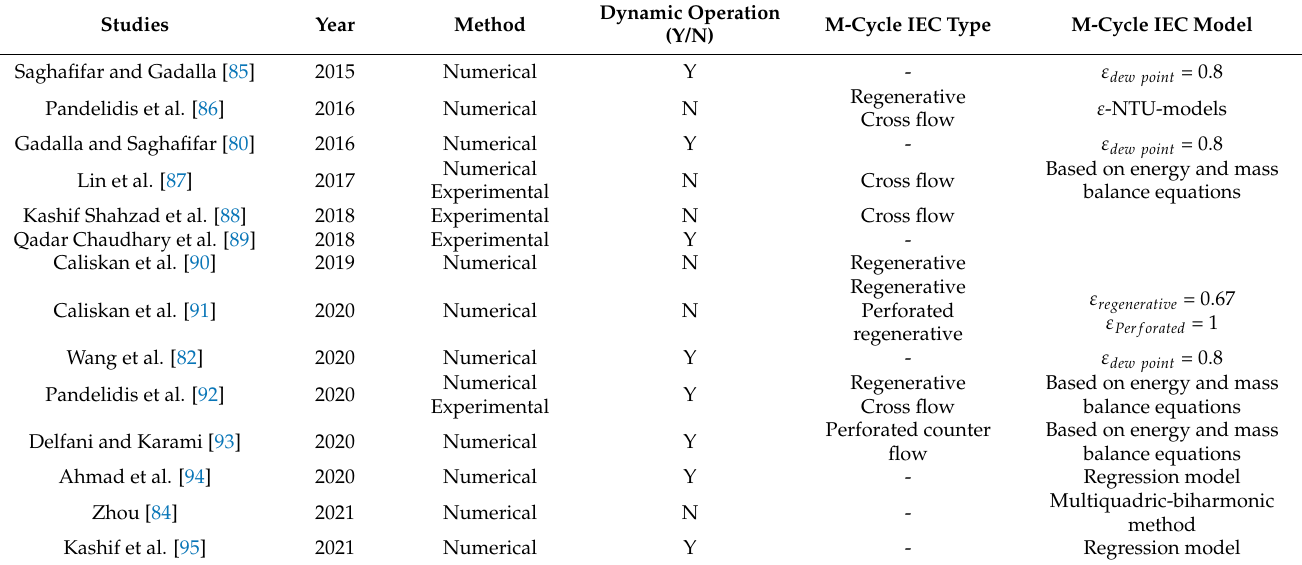
Table 2. Studies of solid desiccant evaporative cooling system using M-cycle IEC.